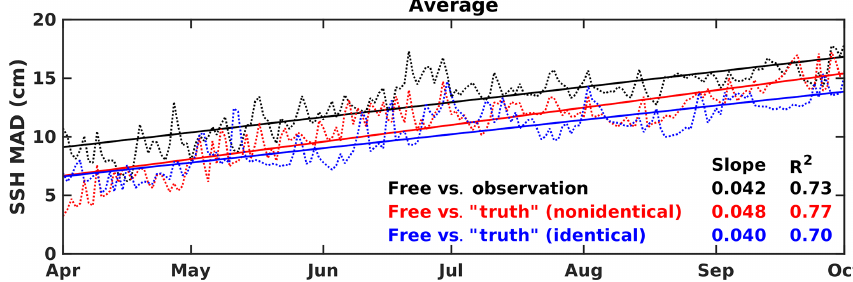
Figure 2. Time series of MAD error (cm) averaged over the open gulf (excluding shelf regions shallower than 300m) for the free run SSH relative to the SSH from the satellite observation (black dashed line), the “truth” in the nonidentical (red) and identical (blue) twin experiments, respectively. The corresponding colored solid lines are linear regressions of the time series, wherein the slope values represent the respective MAD error growth rate (cmd − 1 ).